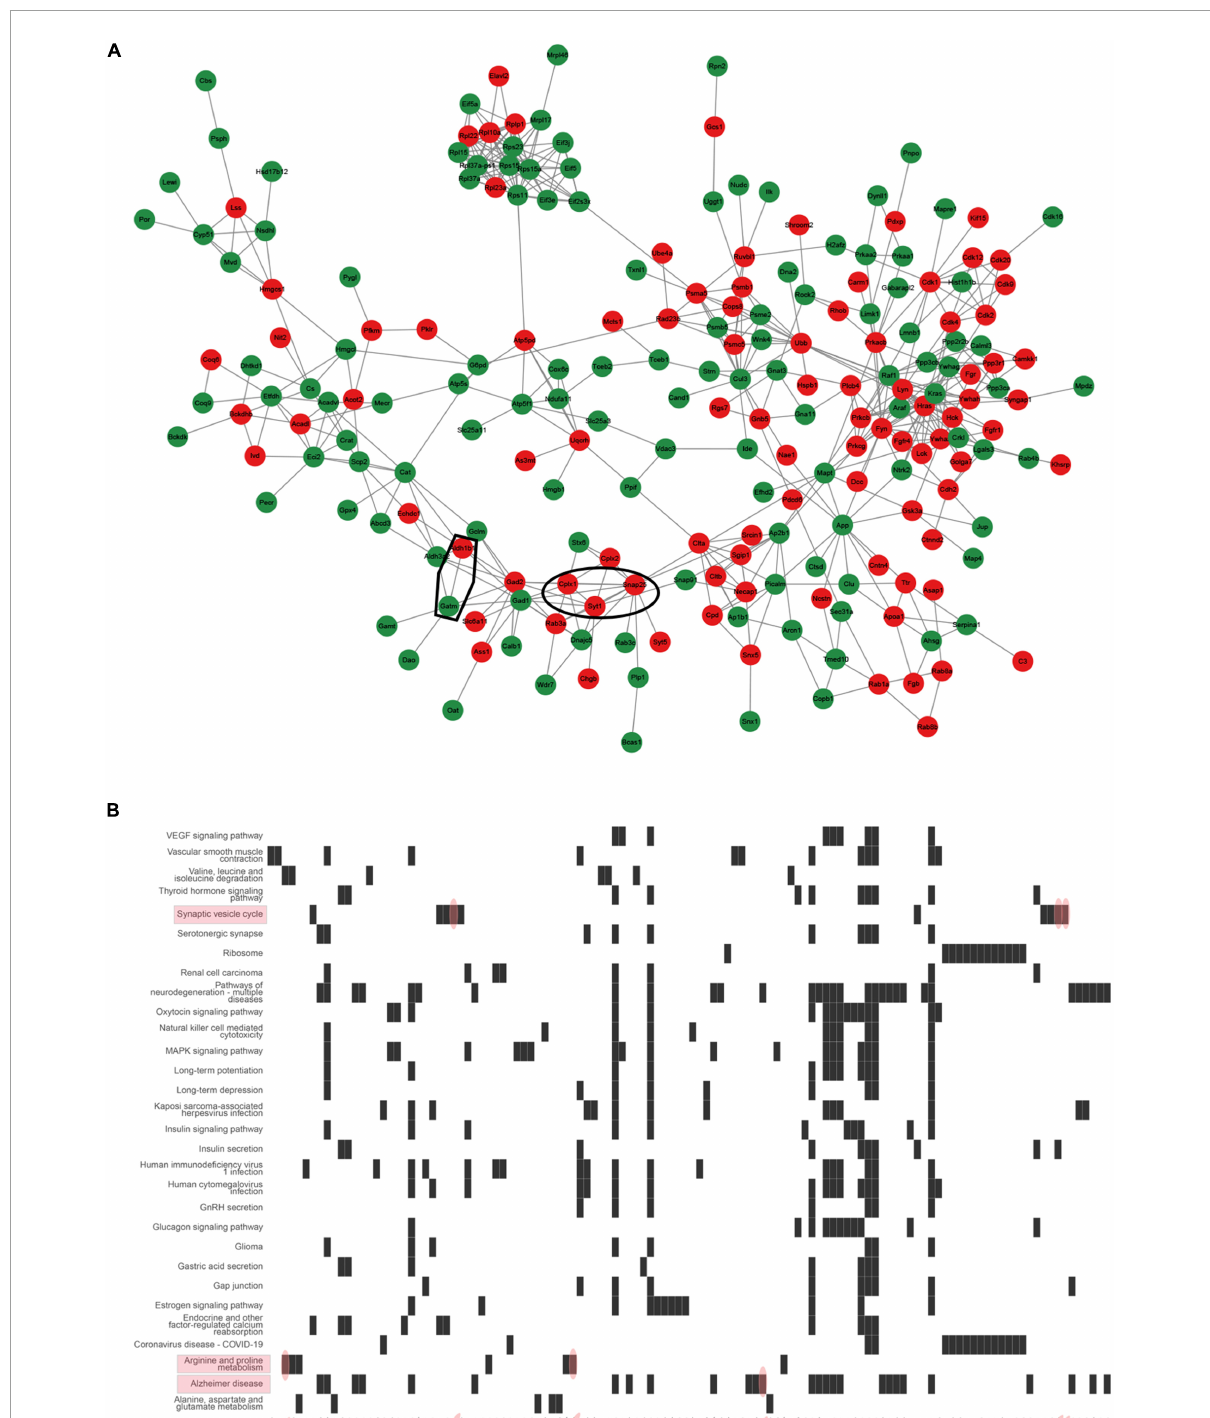
FIGURE5 Interaction networks analyzed for differentially expressed proteins (DEPs). (A) STRING protein–protein interaction network of DEPs colored nodes indicates the individual protein identified. Lines between nodes represent the direct and indirect association of proteins. Red color presented up-regulated proteins. Green color presented down-regulated proteins. Circle 1: synaptic interaction proteins such as CPLX1, SNAP25, and SYT1 proteins. Circle 2: mitochondrial interaction proteins such as ALDH1B and GATM. (B) Heatplot presents differentially expressed proteins related to the pathway. Red ovals indicated proteins such as CPLX1, SNAP25, and SYT1 involved in the synaptic vesicle cycle pathway, and ALDH1B and GATM involved in arginine and proline